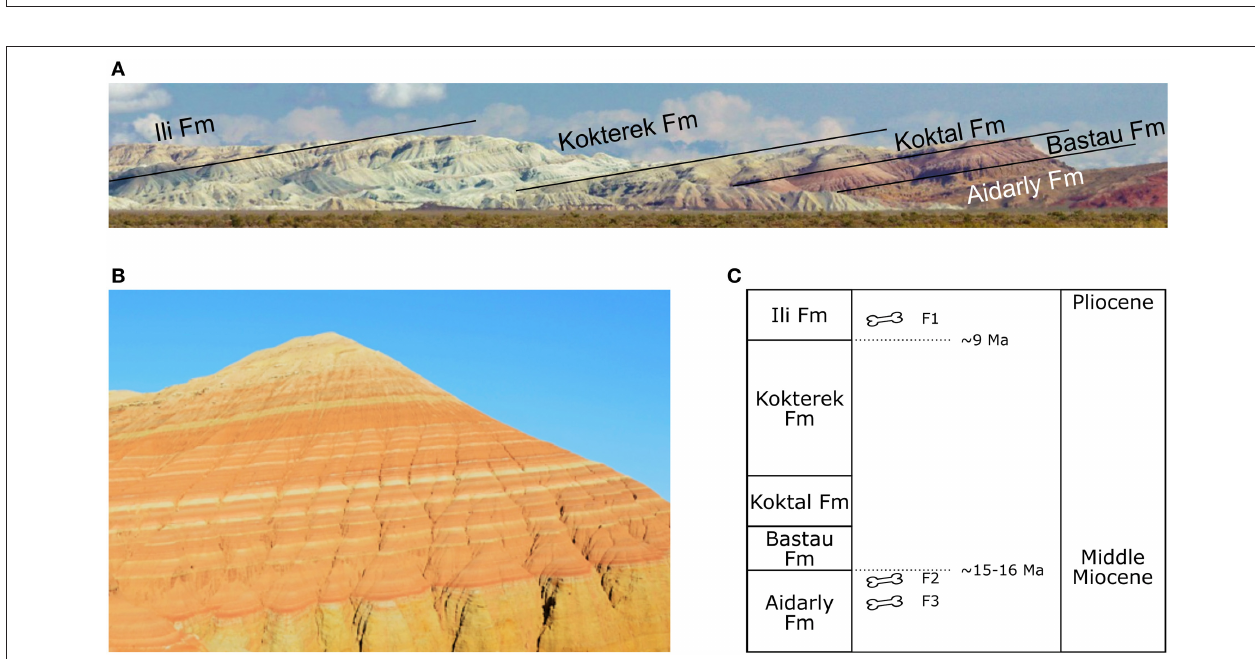
FIGURE 2 | (A) Cenozoic succession of the Aktau Mountains with the stratigraphic formations after Voigt et al. (2017), (B) image of the 90 m-thick Bastau Fm with the dominant red siltstones (photo by J. Pross), (C) biostratigraphic overview with marker fossil records: F1 after Bazhanov and Kostenko (1961), and Dzhamangaraeva (1997), F2 and F3 after Lucas et al.